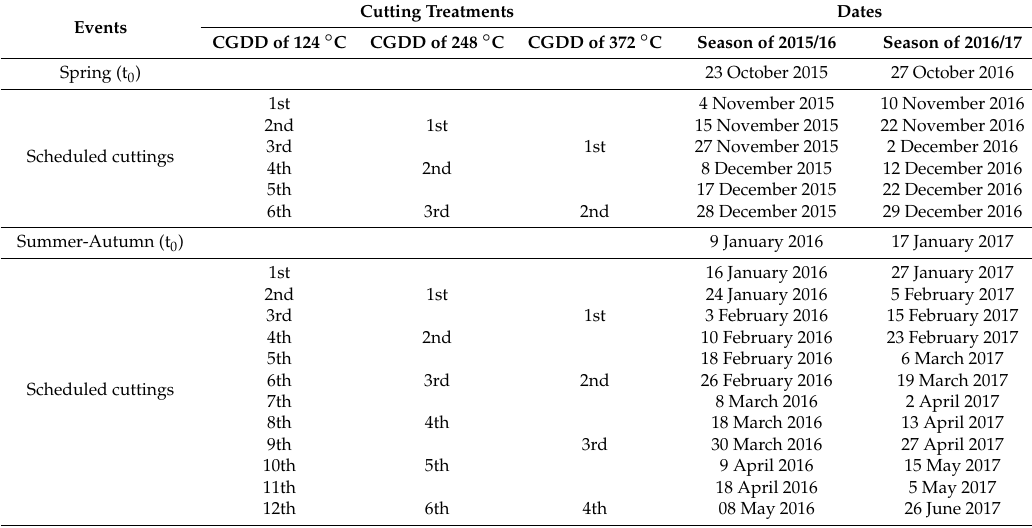
Table 2. Cuttings dates of the various treatments having different cumulative growing degree days (CGDD) intervals between